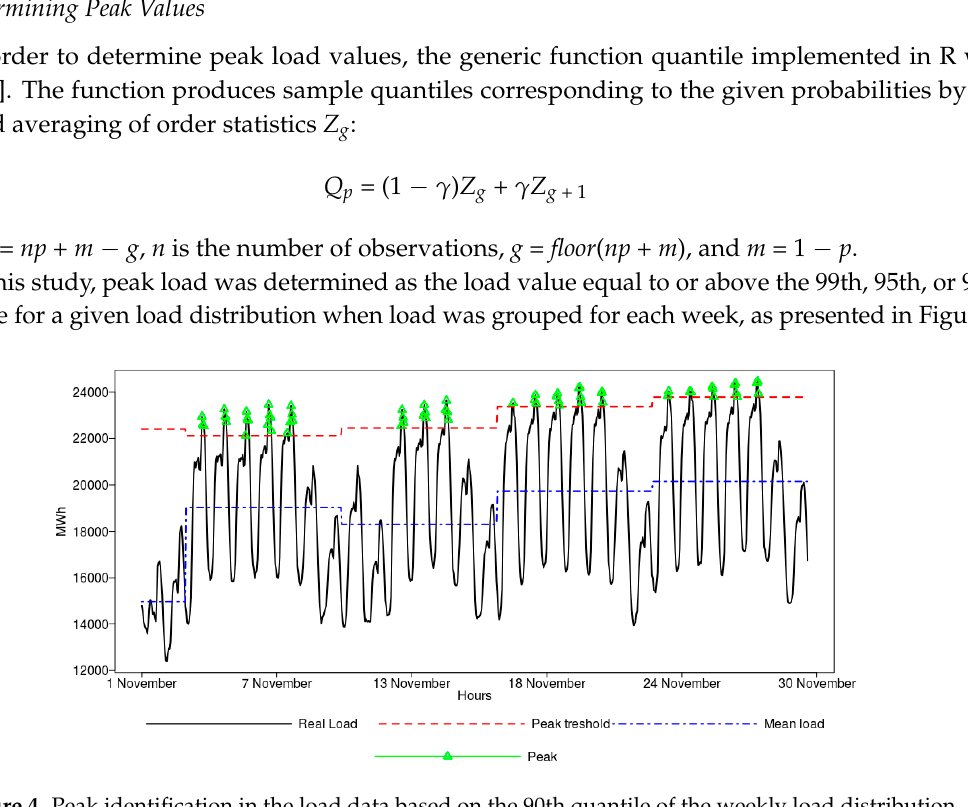
Figure 4. Peak identification in the load data based on the 90th quantile of the weekly load distribution (November 2015 data).